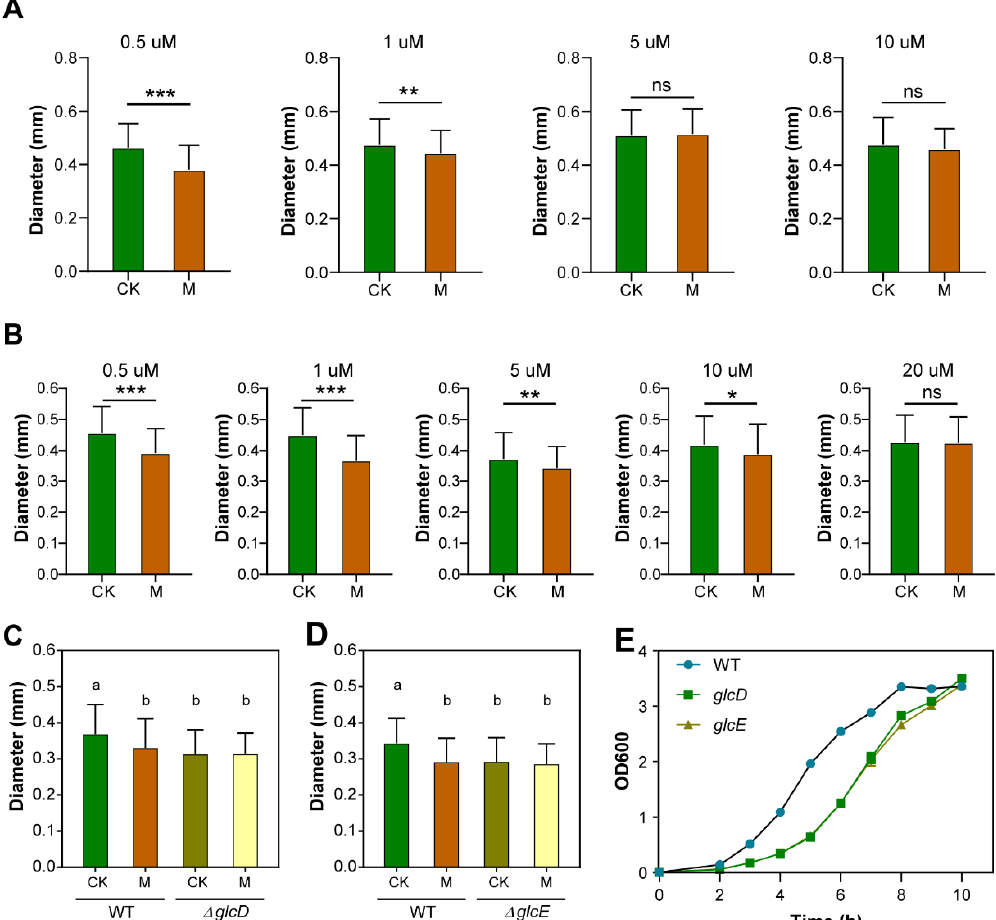
Figure 4. Effect of glycolate oxidase on SMF-inhibited E. coli growth. ( A ) Colony diameter of E. coli cultured on solid LB medium with various glyoxylate levels. ( B ) Colony diameter of E. coli cultured on solid LB medium with various glycolate levels. ( C ) Effect of glcD mutations on colony diameter of E. coli . ( D ) Effect of glcE mutations on colony diameter of E. coli . ( E ) Growth curves of E. coli TOP10 strain (WT) and glcD , glcE mutant strains under GMF condition. Data shown as mean ± SD. n > 50. Statistical analysis was performed by t -test. ns p > 0.05, * p < 0.05, ** p < 0.01, *** p < 0.001. Lowercase letters on the top of bar plots in ( C , D ) indicate significantly different groups as determined by one-way ANOVA with post-hoc Tukey HSD testing ( p < 0.001).